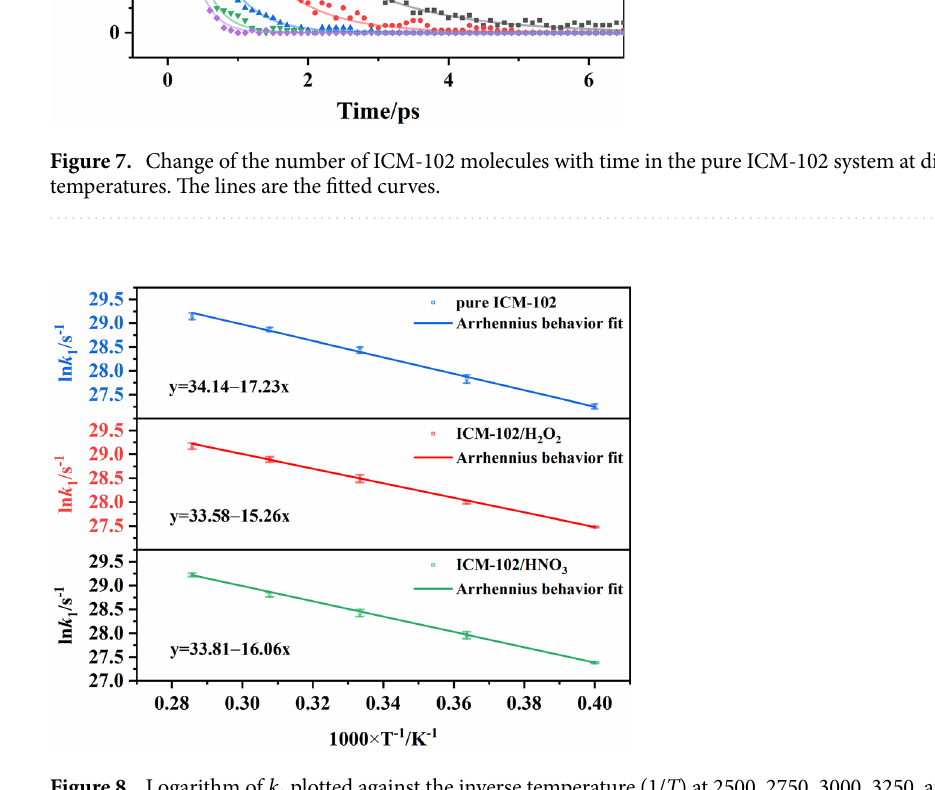
Figure 8. Logarithm of k 1 plotted against the inverse temperature (1/ T ) at 2500, 2750, 3000, 3250, and 3500